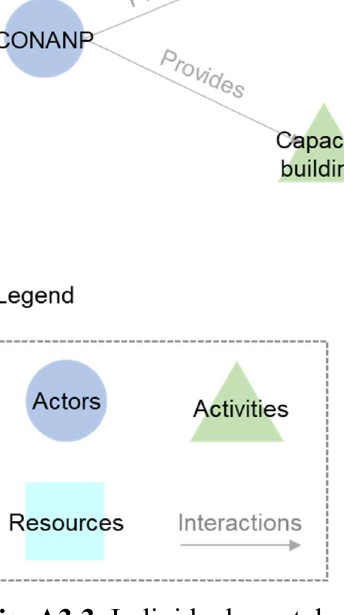
Fig. A3.3. Individual mental models of eleven members of Luchadores del Castaño fishing